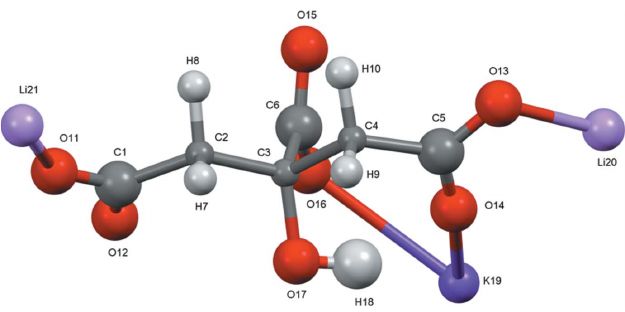
Figure 1 The asymmetric unit of Li 2 KC 6 H 5 O 7 with the atom numbering and 50% probability spheres.